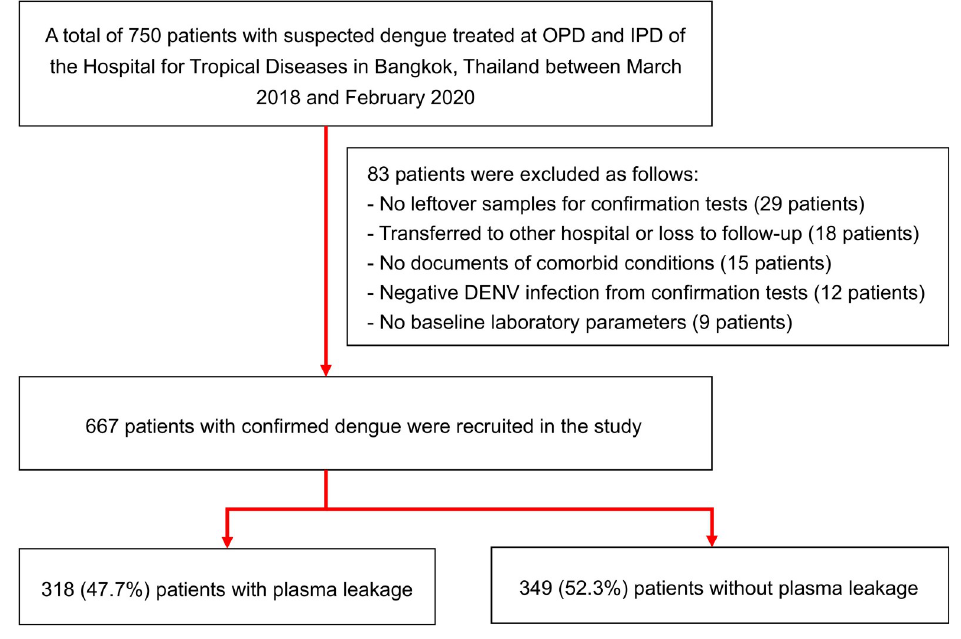
Fig 1. Flow diagram showing the enrollment of study patients. DENV, dengue virus; IPD, inpatient department; OPD, outpatient department.